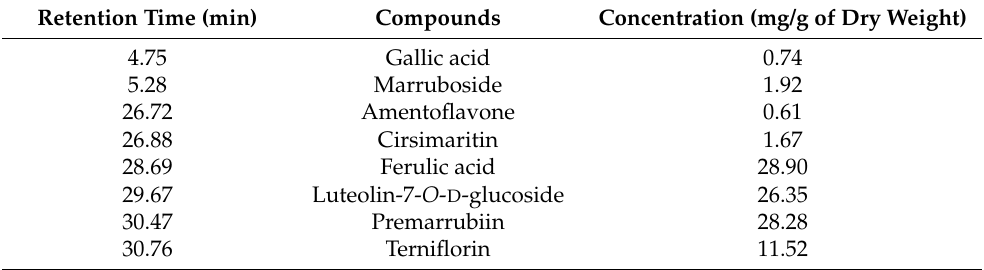
Table 1. Chemical identification by HPLC of methanolic extract of Marrubium vulgare